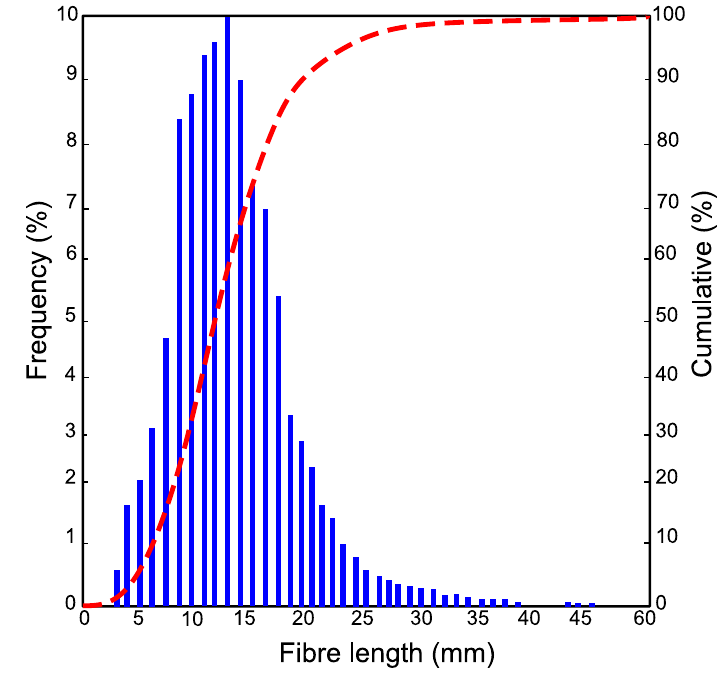
Figure 6. RTSF length distribution.